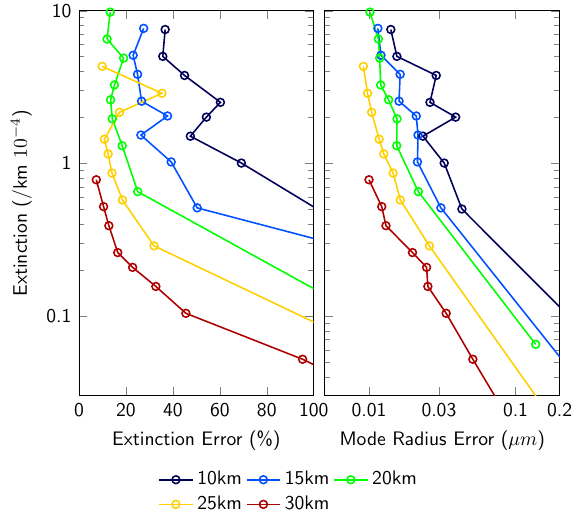
a mode width of 1.6. Relative extinction error is shown in the left panel with the relative mode radius error shown on the right.